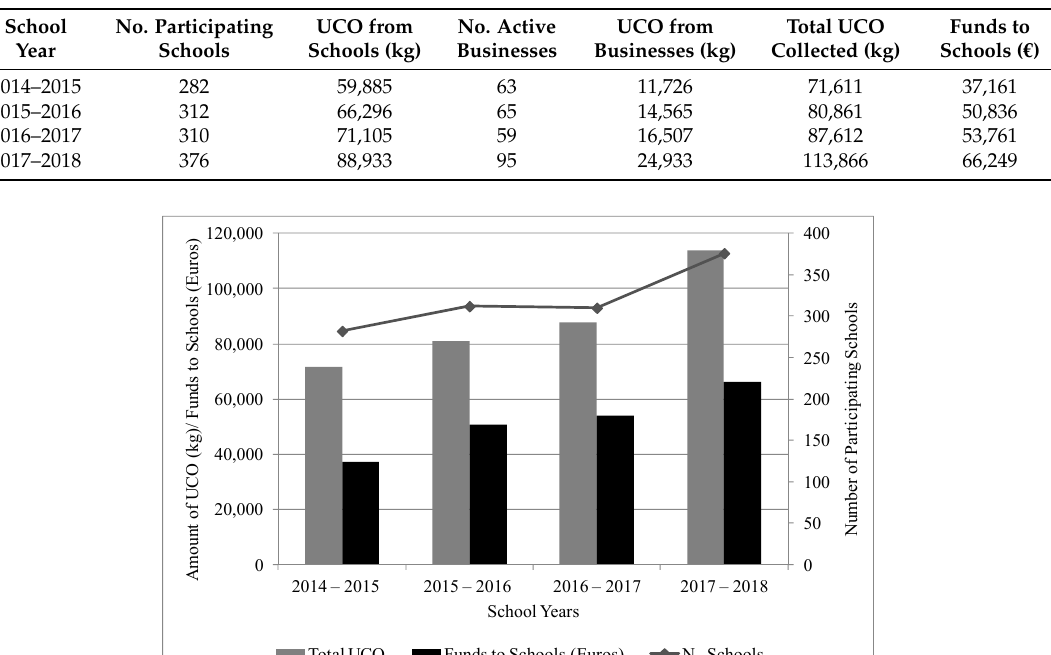
Table 1. Evolution of InnovOleum’s implementation in Cyprus.